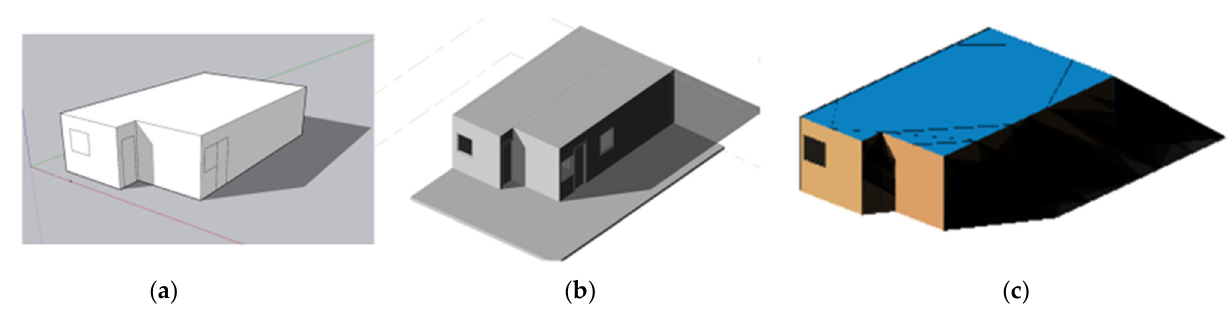
Figure 13. Shading analysis in ( a ) Sketchup 2021, ( b ) Revit 2023 (educational), and ( c ) Helidon2.